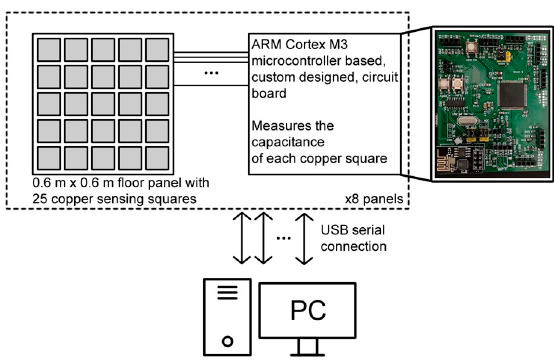
Figure 3. System architecture showcasing the pc–board–panel connections.